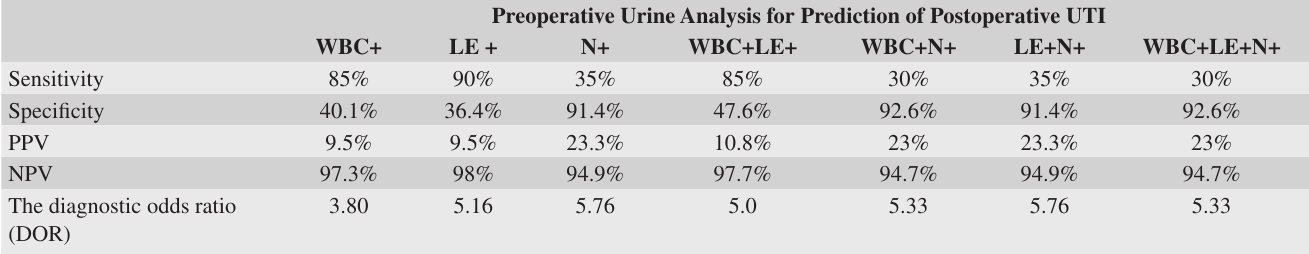
Table 3. Urine Analysis as a Predictor of Postoperative UTI